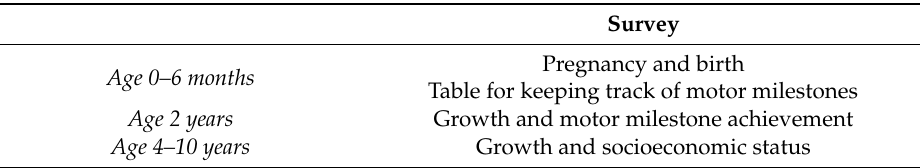
Table 1. Data collection of twins from the Young Netherlands Twin Register (YNTR).